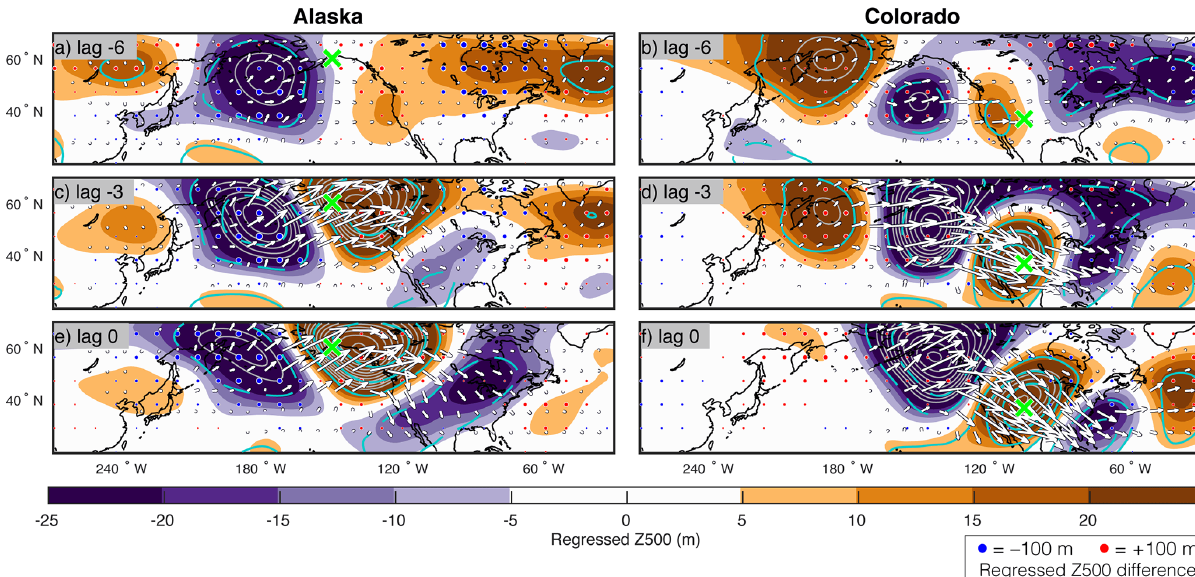
Figure 9. One-point regression maps of Z 500 anomalies (color shading) with respect to reference SAT time series over (a, c, e) Alaska (61 ◦ N, 150 ◦ W) and (b, d, f) Colorado (39 ◦ N, 105 ◦ W). The corresponding correlation is superimposed with cyan contours (increments of 0.2). The regression is performed separately for years when SVD1 SST ≥ 0 . 75 and SVD1 SST ≤ − 0 . 75 (indicated with blue crosses and circles in Fig. 1, respectively), and the average of the two patterns is shown in this figure. The reference SAT time series for the positive and negative phases are normalized independently before carrying out the regression. Differences between the SVD1 SST ≥ 0 . 75 and SVD1 SST ≤ − 0 . 75 patterns that are significant at the α FDR = 0 . 1 significance level are shown with blue dots for negative differences and red dots for positive differences. The dots are scaled according to the magnitude of the difference. For reference, the dots illustrated in the legend represent a difference of 100m. The wave-activity flux (Takaya and Nakamura, 2001) evaluated with the regressed Z 500 anomalies is shown with white arrows with a distance of 1 ◦ corresponding to a flux of 2 / 3m 2 s − 2